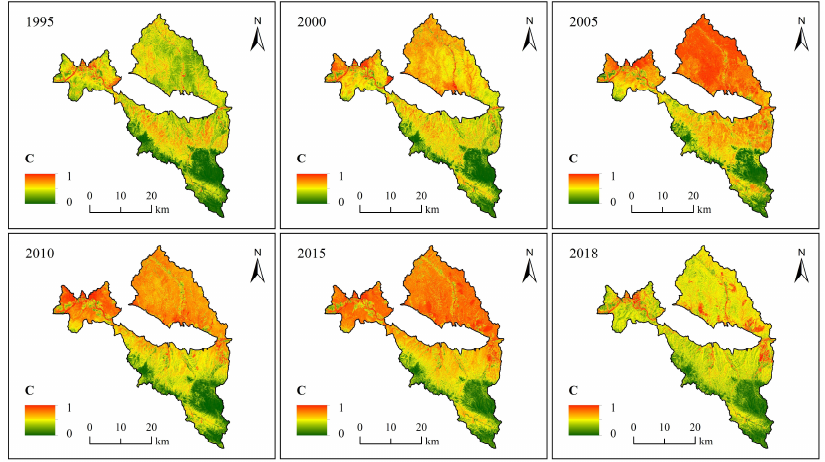
Figure 5. Spatial distribution of vegetation cover and management factors in the South and